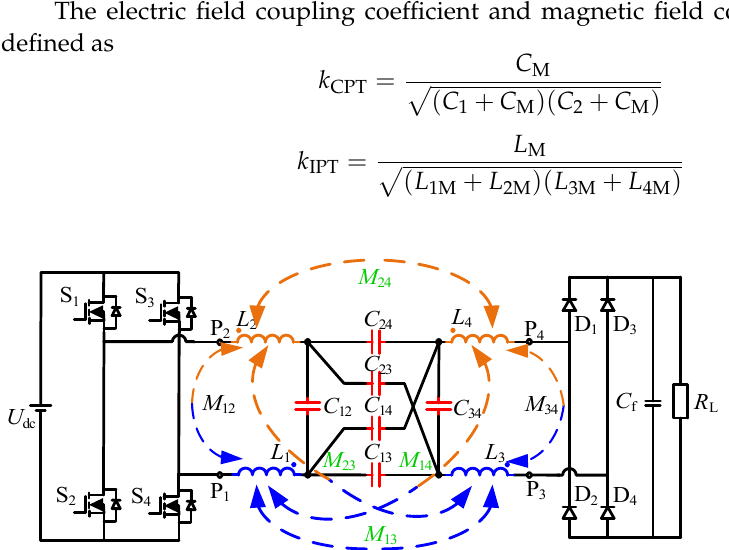
Figure 3. Circuit topology of WPT system without compensation.